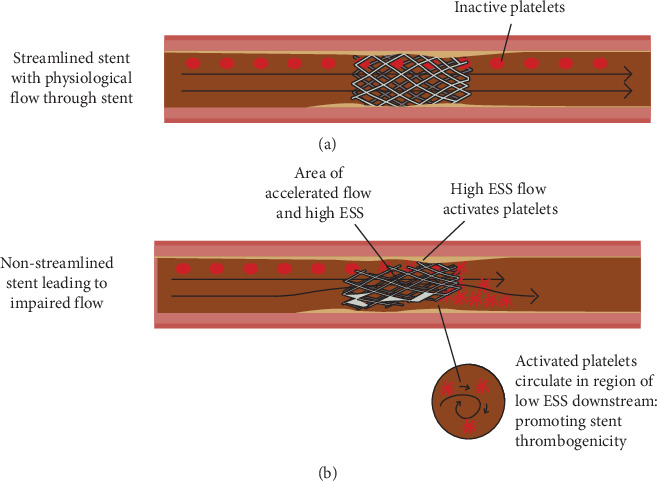
(a) Physiological flow through a well-positioned and expanded stent, facilitating re-endothelialization and inhibiting thrombus generation. (b) Poorly deployed stent leads to a region of accelerated flow and high ESS over the stenotic portion of the stent surface, which activates platelets to release vasoactive mediators including adenosine diphosphate. Adenosine phosphate along with downstream low ESS increases the local concentration of activated platelets, leading to increased stent thrombogenicity.